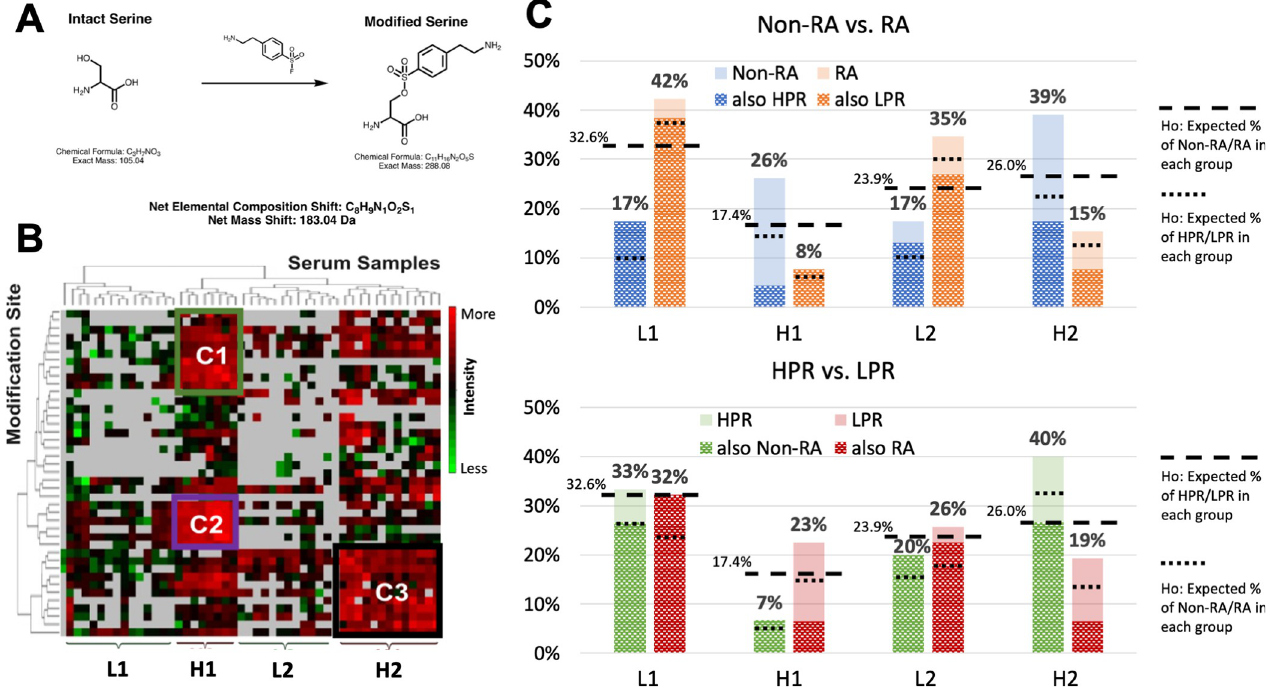
Fig 5. AEBSF modification of HSA. (A) The chemical reaction of the AEBSF modification on Serine. The reaction is similar for other nucleophilic amino acids. (B) The heatmap generated with PNNL Inferno showing the intensity differences of AEBSF modification at different HSA sites between different samples. The AEBSF modification amino acid number for HSA is listed on the y-axis, and the serum sample number on the x-axis. The samples are separated into 4 groups according to the hierarchy branch of serum samples, from left to right (S5 Data) . Group L1 and L2’s AEBSF modifications are less intense than group H1 and H2 (L stands for lower intensity and H stands for higher intensity). The three clusters, C1 (green), C2 (purple), and C3 (black), are the most intense AEBSF modification clusters and are examined to characterize the modification further. (C) The bar graph shows the number of RA/non-RA and HPR/ LPR samples expected in each AEBSF modification group (L1, H1, L2, H2). The percentage of RA samples in L1, H1, L2, H2, is 73%, 25%, 69%, and 31% respectively. For LPR, it is 67%, 89%, 73%, and 50%, respectively.